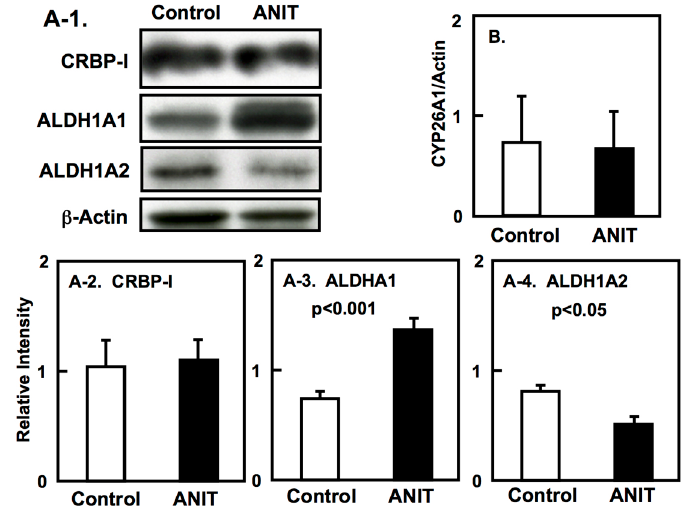
Figure 7. Hepatic expression of ALDH1A1, ALDH1A2, CRBP-I and CYP26A1 in control and ANIT rats. ( A ) Hepatic protein levels of CRBP-I (A-1, 2), ALDH1A1 (A-1, 3), ALDH1A2 (A-1, 4), and in control and ANIT rats ( n = 3 for each group) were analyzed by immunoblotting using suitable antibodies. Hepatic β -actin was used as the loading control. ( B ) The hepatic mRNA levels of CYP26A1 in both groups ( n = 5 for each group) were examined by quantitative real-time PCR. Each bar represents the mean value ± SD and significant differences are indicated in the graph.